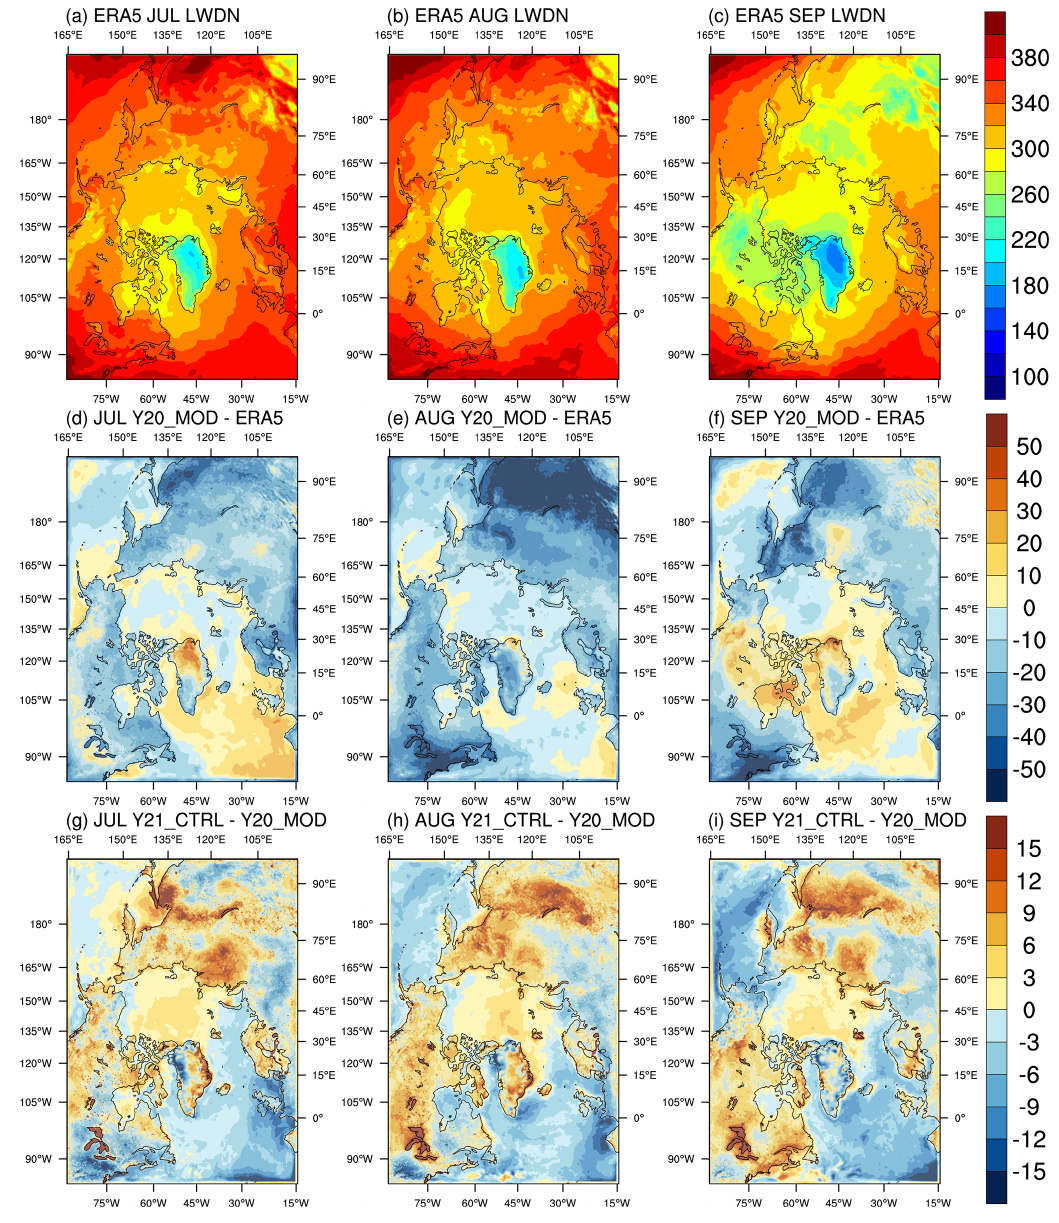
Figure 2. Same as Fig. 1 but for downward thermal radiation at the